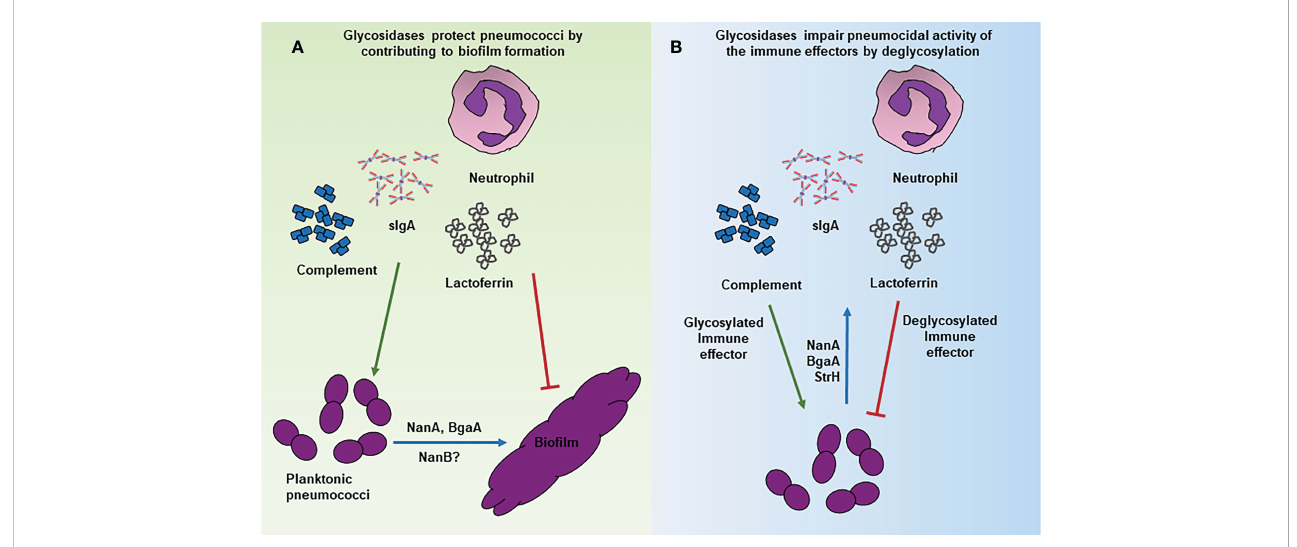
FIGURE 2 Mechanisms of glycosidase mediated immune evasion by S. pneumoniae. Schematic representation of various mechanisms through which surface associated glycosidases contribute to immune evasion. (A) NanA and BgaA contribute to the formation of bio fi lms that are resistant to killing by the complement mediate opsonophagocytosis/phagocytosis. (B) Deglycosylation of the immune effectors such as lactoferrin, IgA2 and complement proteins by NanA and other glycosidases decreases their pneumocidal activities likely by affecting their stability and/or interaction with target